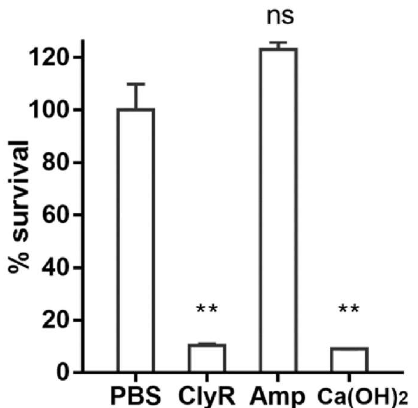
Figure 6. Robust biofilm removal efficacy of ClyR in an ex vivo dental model. E. faecalis ATCC 51299 biofilms grown on dentin slices are treated either with 50 μg/mL ClyR, 50 mg/mL ampicillin, or 0.5% Ca(OH) 2 for 1 h at 37 °C, after washing with PBS, viable cell within biofilm after each treatment is recovered by plating on BHI agar, and compared with that of PBS treated controls by Two-tailed Student’s t test. Data is shown as mean ± standard deviation, and ns: not significant; ** p <